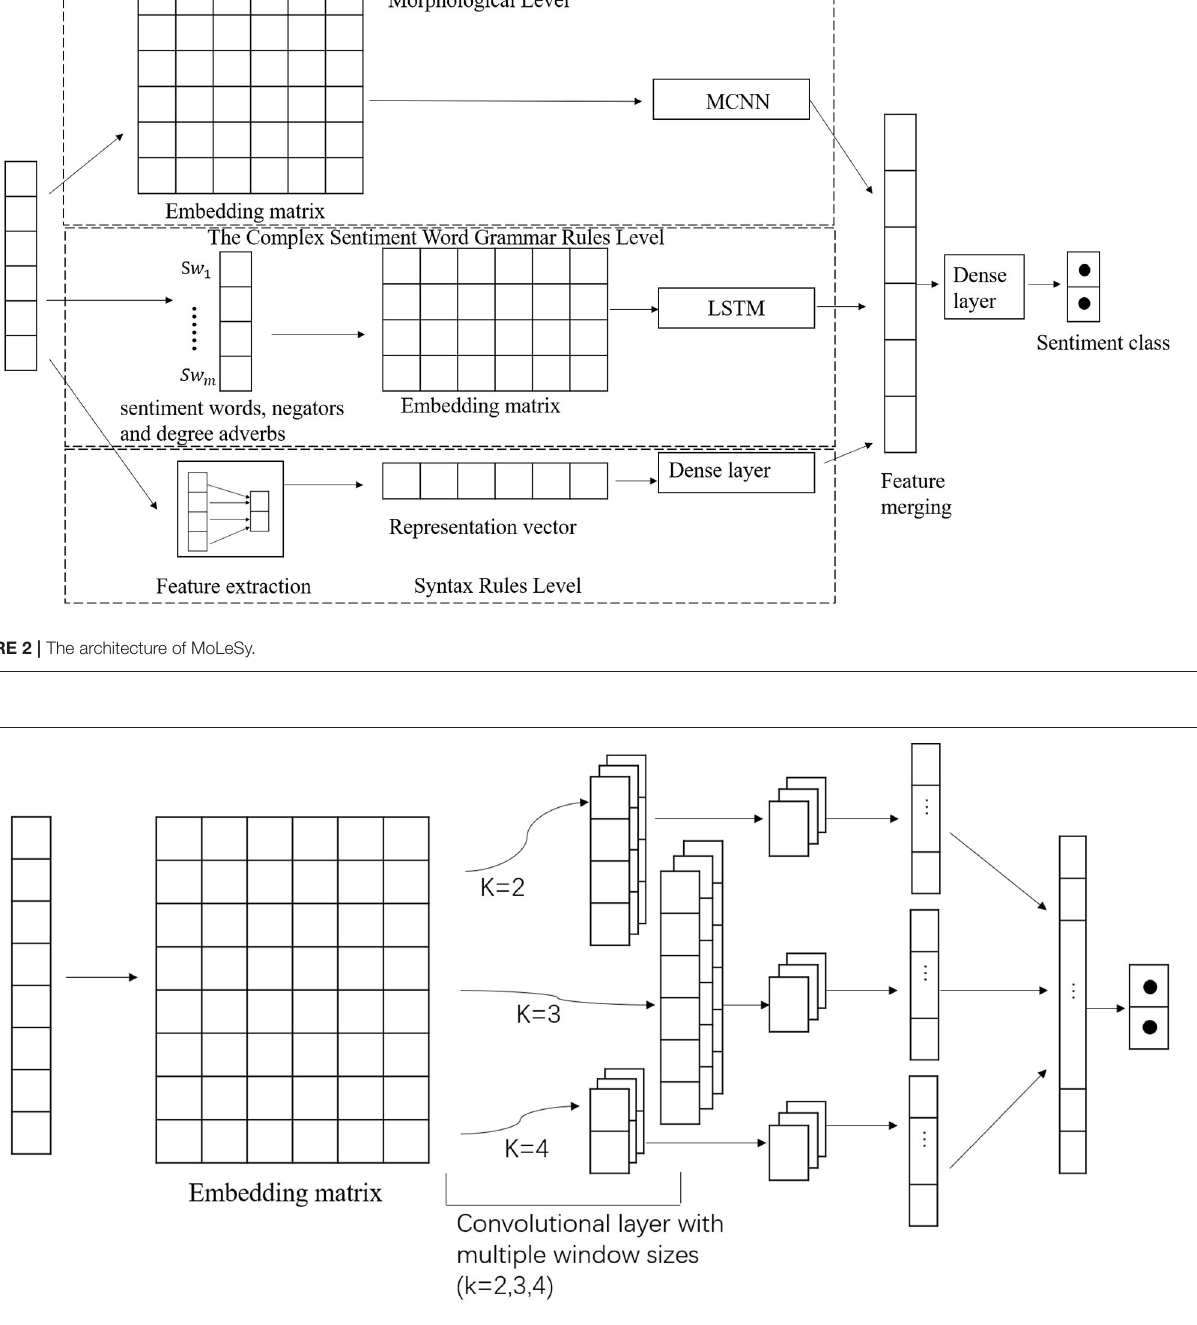
FIGURE 3 | The architecture of multichannel convolutional neural network